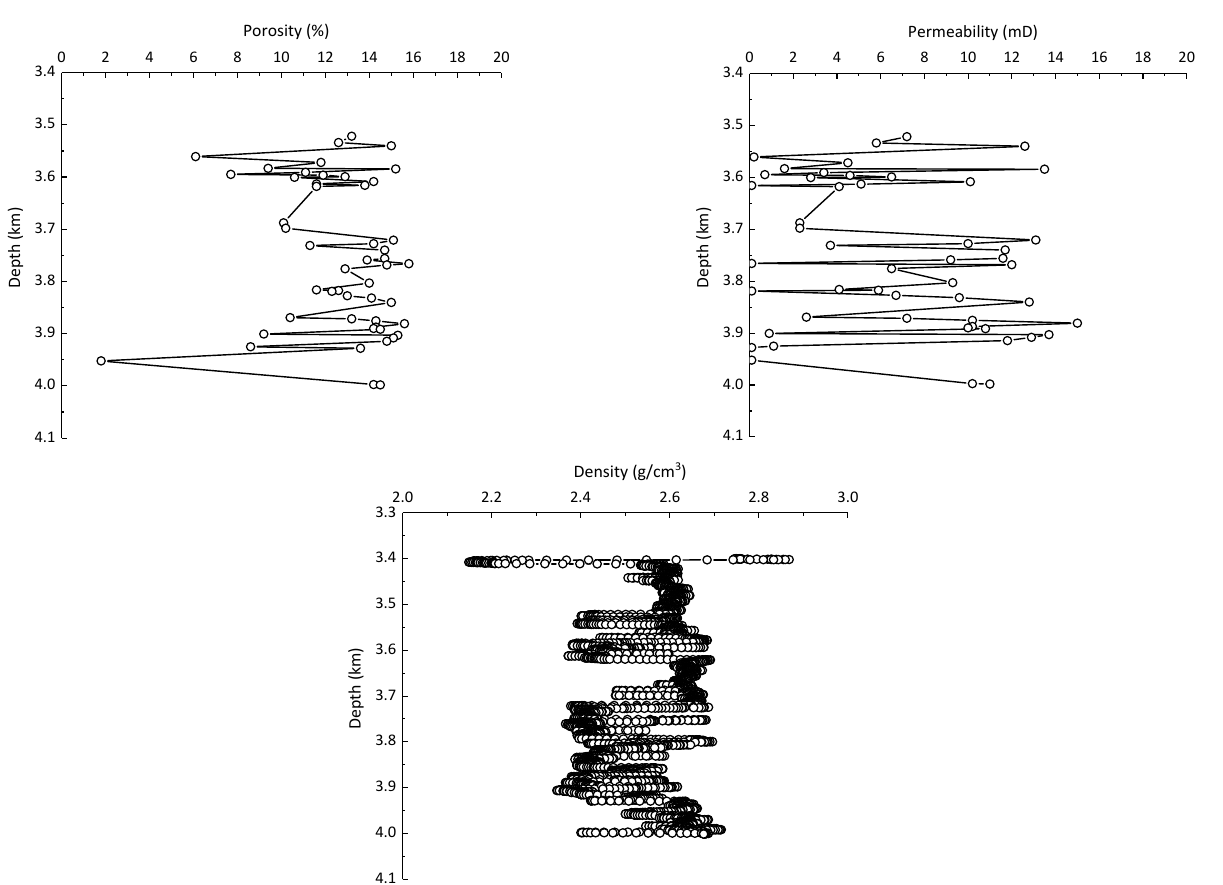
Figure 3. Changes in initial porosity, permeability, and density with depth near well X-3 . The change in formation pressure will lead to formation rock deformation and then affect the change in formation porosity and permeability. As shown in Figure 4, this paper considered the dynamic change in permeability with porosity. The solid line was an ap- proximation of the actual survey.